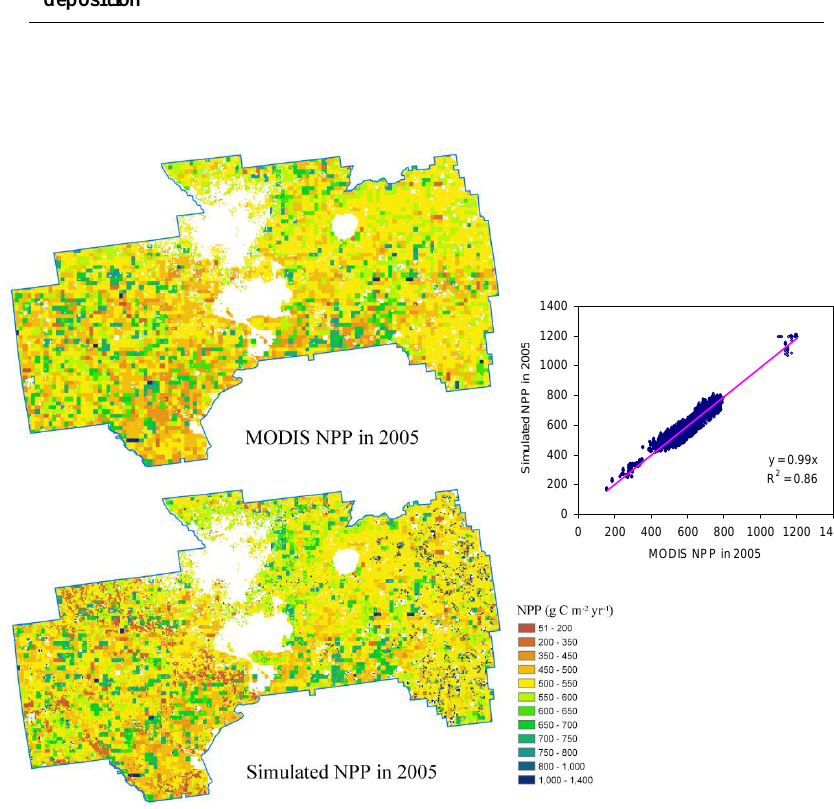
Fig. 3. Comparison of GEMS simulated ( Y ) and MODIS NPP ( X ) in 2005 ( Y = 0 . 99 X , R 2 = 0 . 86, n = 43 166).